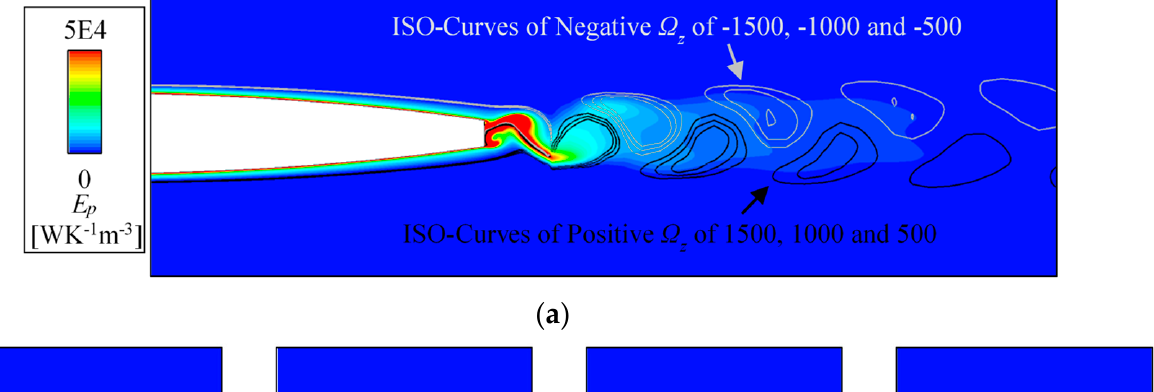
Figure 8. Temporal variation of vortex shedding with interactions. ( a ) Pattern of entropy production and Ω z at a specific time step. ( b ) Pattern of 8 continual time steps with 0.0001 s between every two steps.